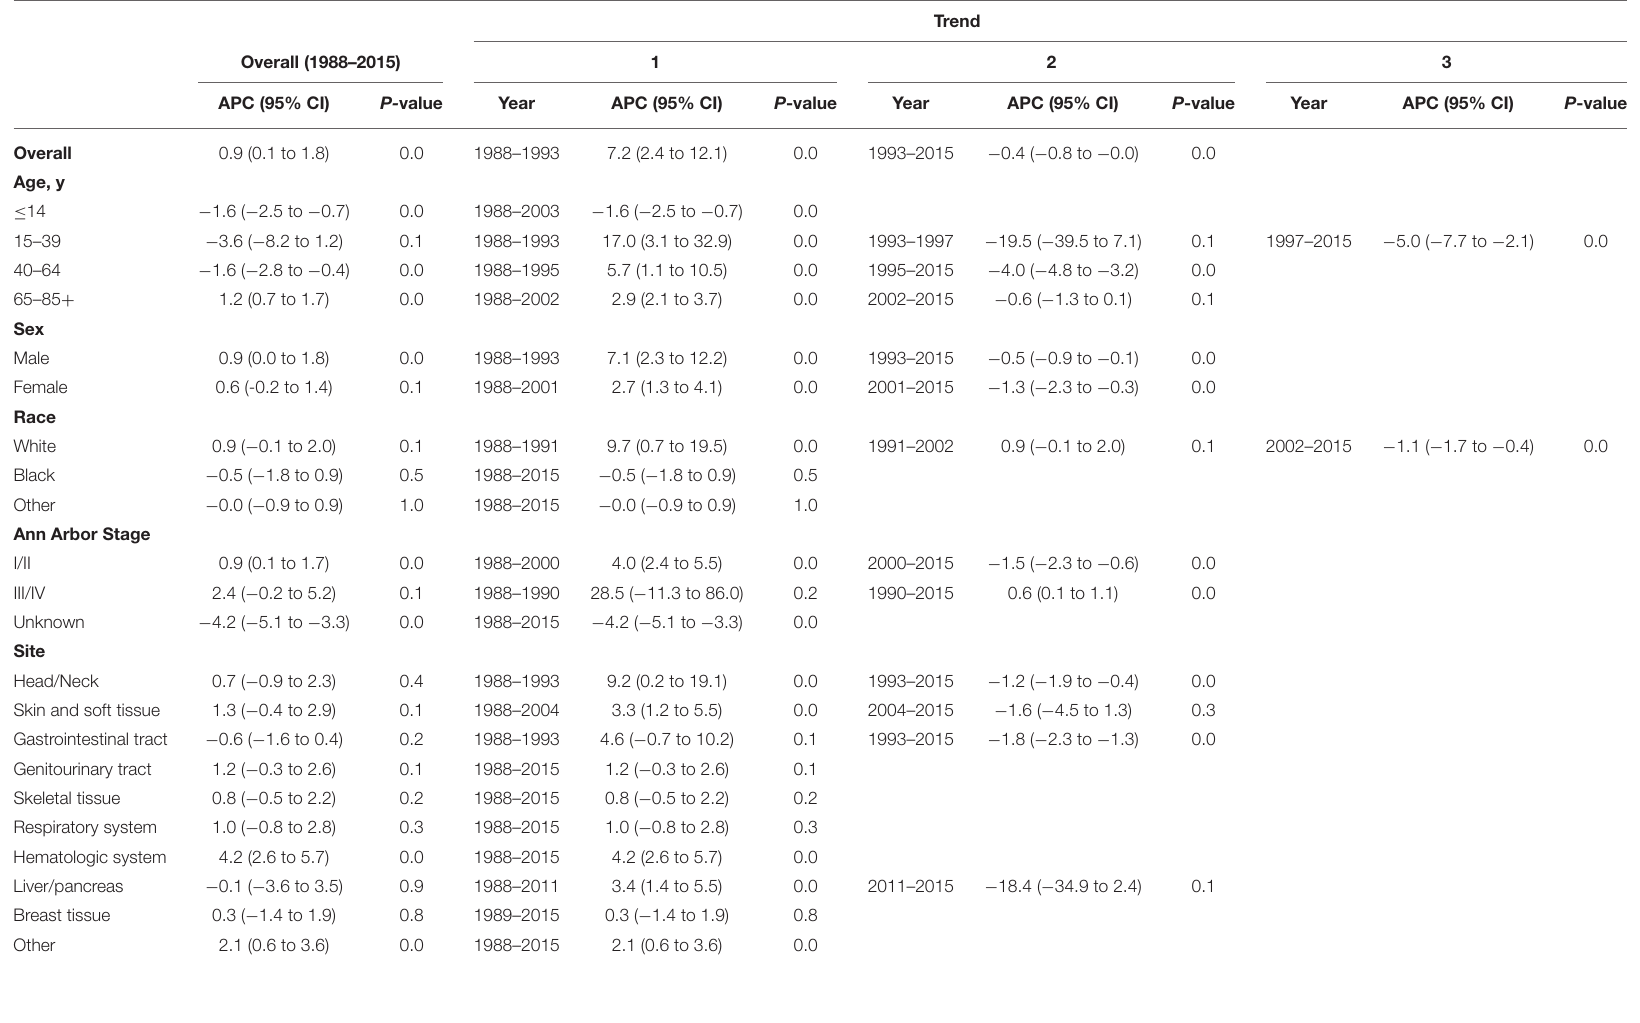
TABLE 3 | Trends in extranodal diffuse large B-cell lymphoma incidence-based mortality rates (1988–2015): the SEER-9 registry database.